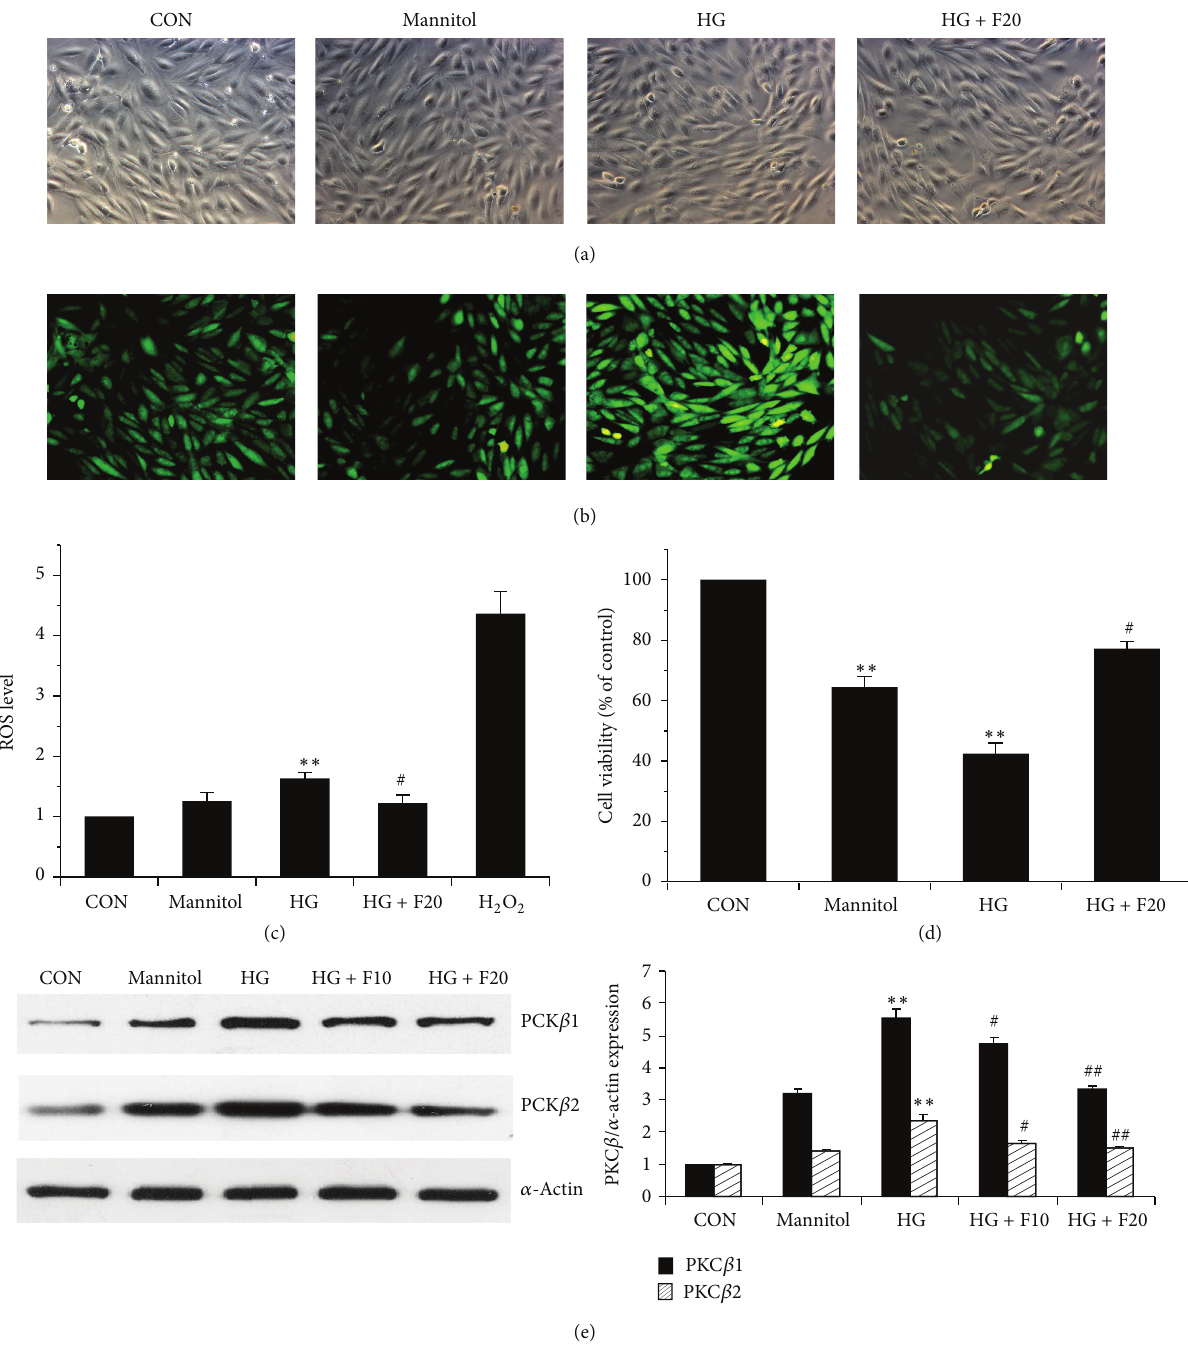
Figure 6: LMWF directly inhibited PKC 𝛽 -mediated ROS production in H9c2 cells induced by high glucose. ((a), (b)) H9c2 cells were incubated in normal glucose (NG, 5.5 mM D-glucose) and treated with high glucose (HG, 25 mM D-glucose) without or with LMWF (20 𝜇 g/mL) treatment for 24 h. D-mannitol (20mM) was used as an osmotic control. Then cells were incubated with 20 𝜇 M H 2 DCF-DA at 37 ∘ C for 45 min. After washing with PBS, fluorescence intensity was examined by fluorescence microscope (excitation wavelength = 485 nm, exposure time = 10ms). The micrographs were taken by both light and fluorescence microscopes in the same fields. (c) H9c2 cells were seeded in 96-well microplates and subjected to the same treatment as above to detect ROS production. H 2 O 2 was used as a positive control. (d) H9c2 cells were seeded in 96-well plates and subjected to the same treatment as above, after 72 h, cell viability was determined by MTT assay. (e) H9c2 cells were seeded in 6-well plates and were treated with HG (25 mM D-glucose) without or with LMWF (10, 20 𝜇 g/mL) treatment for 48 h. Then cells were harvested and protein lysates were subjected to Western blot analysis of the expression of PKC 𝛽 1 and PKC 𝛽 2 relative to the expression of 𝛼 -actin. The densitometry value of PKC was normalized to that of 𝛼 -actin and statistical analysis was performed. Data are presented as the mean ± SEM. ∗∗ 𝑃 < 0.01 versus control or D-mannitol group, # 𝑃 < 0.05 , ## 𝑃 < 0.01 versus HG